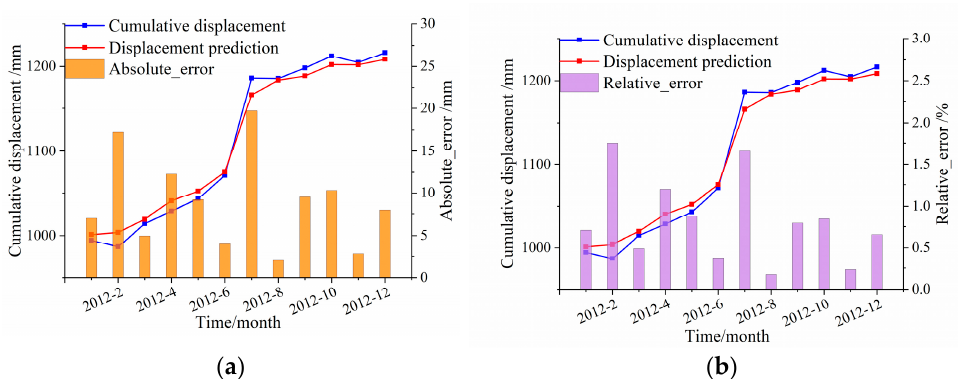
Figure 21. Accuracy comparison results between the predicted value of cumulative displacement and the actual observed value. ( a ) Absolute error. ( b ) Relative error. Table 4. Prediction value and error analysis results of the ZG110 cumulative displacement.